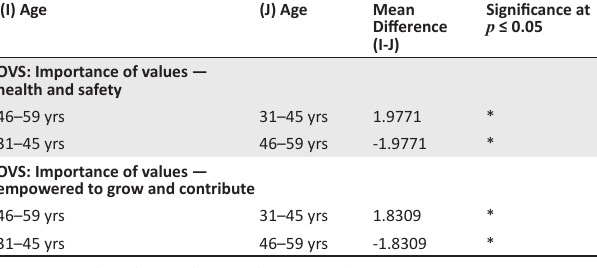
TABLE 4b: Summary of Scheffé Multiple Significant Mean Comparison tests ( n = 988 ):